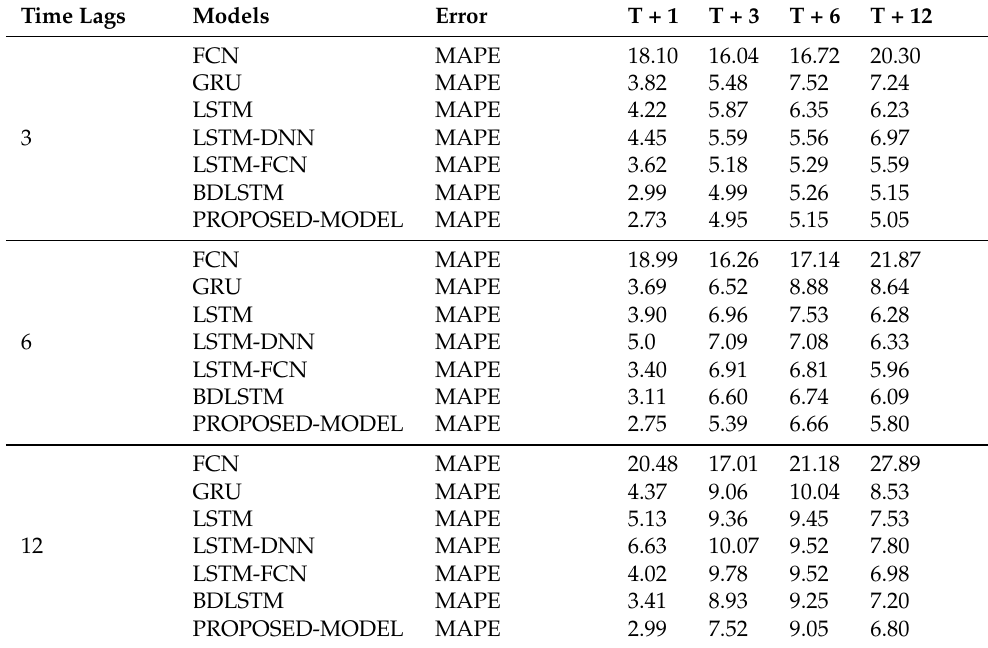
Table 3. Comparison with baseline models(MAPE).